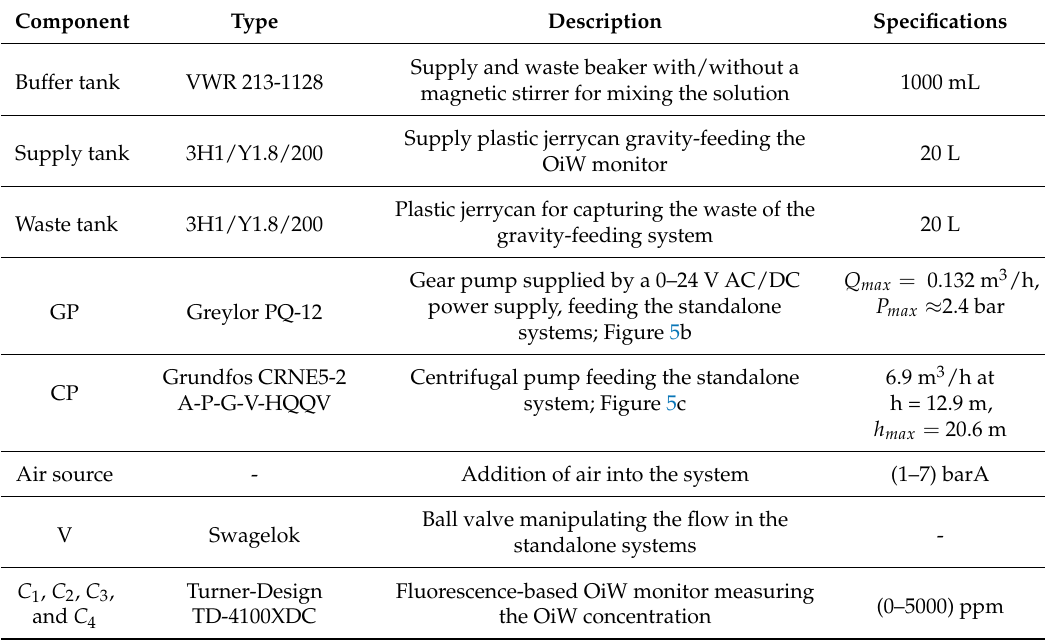
Table 3. Specifications of instruments used for the standalone systems. An illustration of the instruments’ position is seen in Figure